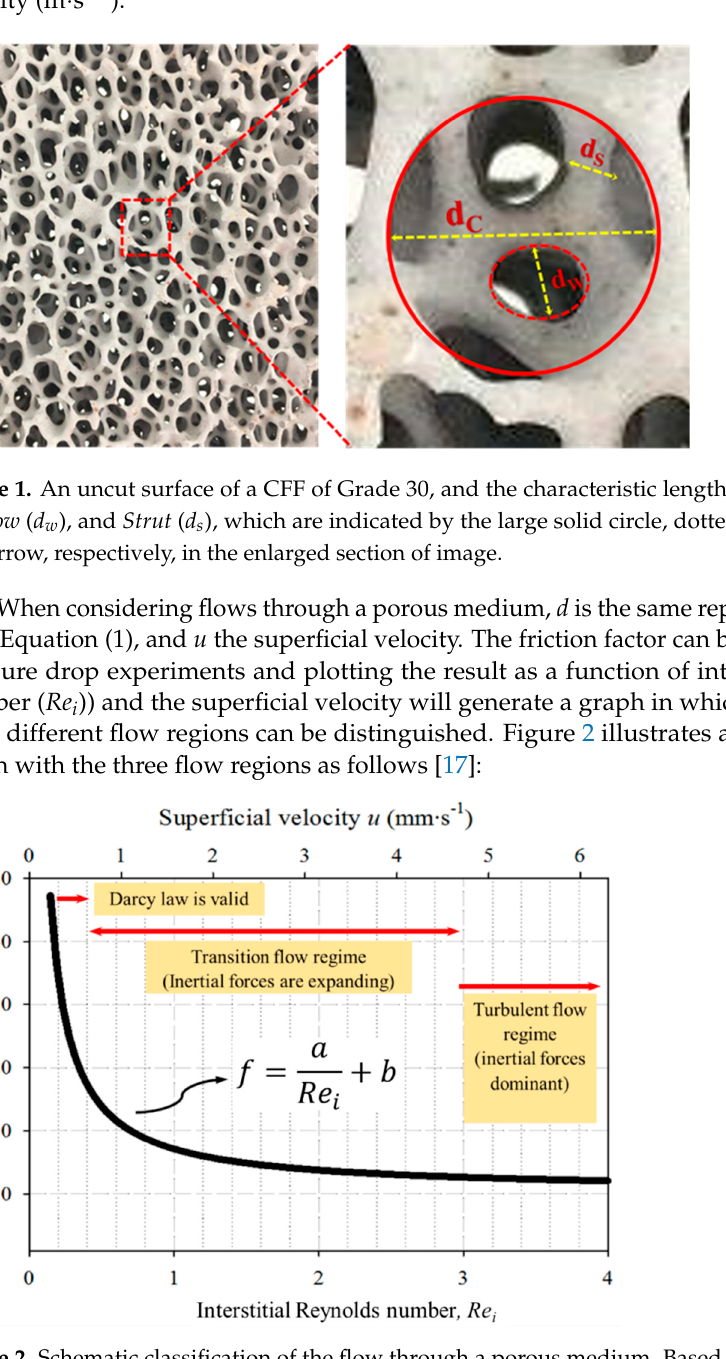
Figure 2. Schematic classi fi cation of the fl ow through a porous medium. Based on reference [17].